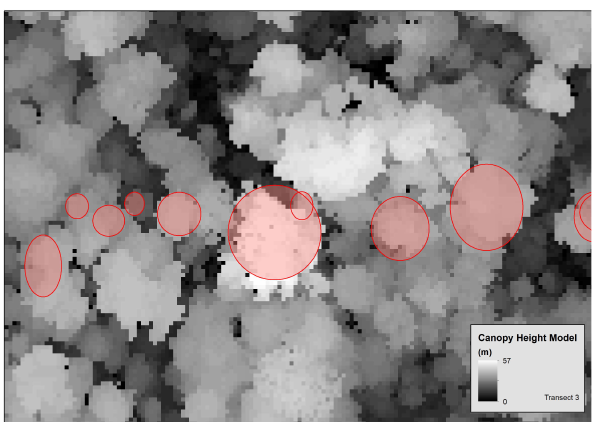
Fig. 1. The canopy height model is shown for a region of Tapajos km 67, with darker shades of grey corresponding to lower canopy heights. Field data collected along a transect within this area in- clude four measurements of crown radius and position. These field data were used to draw crown ellipses for emergent stems that are overlaid on the canopy height